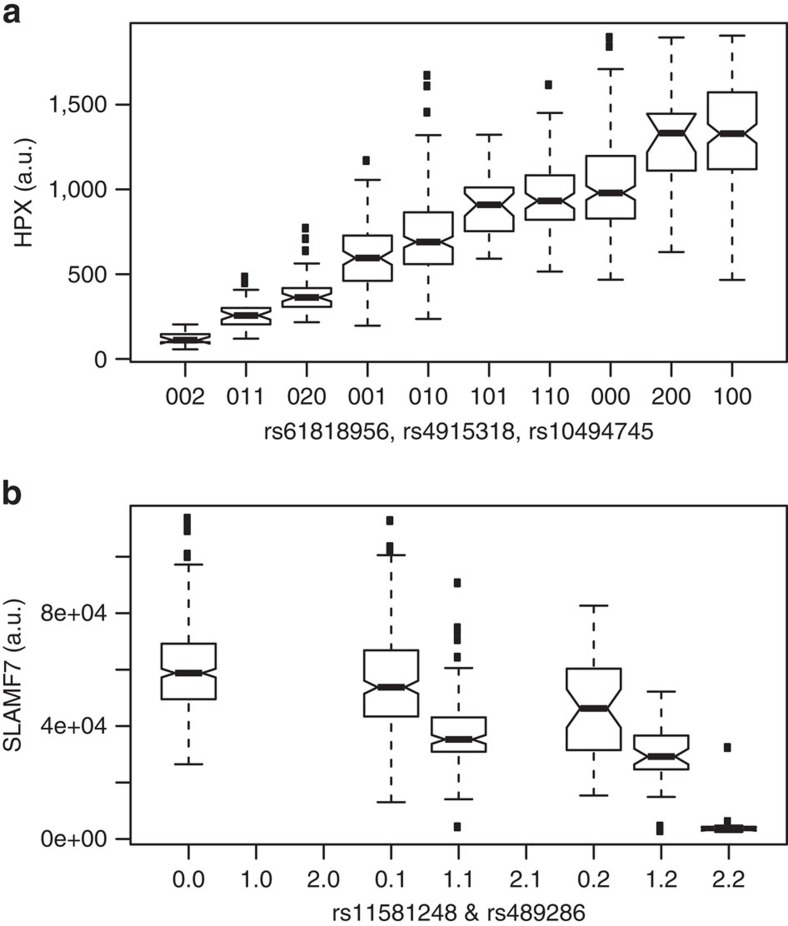
Examples of protein levels that are determined by multiple independent genetic variants.Box-whisker plots of protein levels of (a) Haemopexin HPX and (b) SLAMF7 as a function of genotype. Data presented from the KORA study (N=997). Whiskers extend to the most extreme data point that still falls within the 1.5 inter-quartile range. The number of minor alleles of the respective genetic variant is given; for instance, in a, ‘002' refers to individuals that are homozygous for the major alleles of rs61818956 and rs4915318 and for the minor allele of rs10494745, and in b, ‘0.2' refers to homozygotes of the major allele of rs11581248 and the minor allele of rs489286. Only variant combinations that were observed in the study population are shown in the case of HPX. SNPs rs61818956, rs4915318 and rs10494745 are located in trans in the CFHR2/CFHR4 gene locus. Further examples are shown in Supplementary Fig. 2.